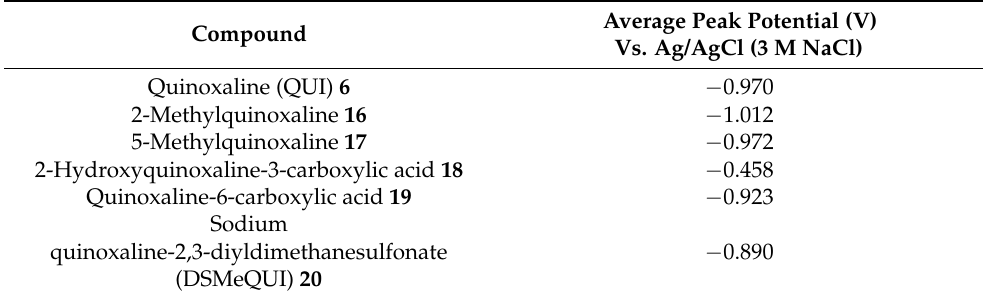
Table 1. Average peak potential of 5 mM solutions of quinoxalines 6 , 16 – 20 dissolved in 0.1 M KOH/0.9 M KCl. All potentials are given versus the Ag/AgCl (3 M NaCl) reference